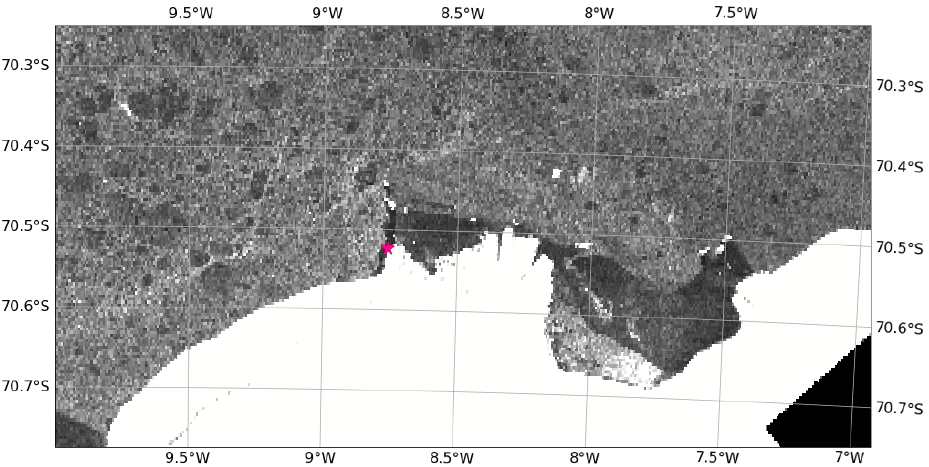
Figure A2. Sentinel-1 SAR image (zoomed in) of the Ekström Ice Shelf and polynya on 12 January 2015 (PS89) (ESA, 2021). The pink star indicates the sampling location for the PS89 tidal observation.